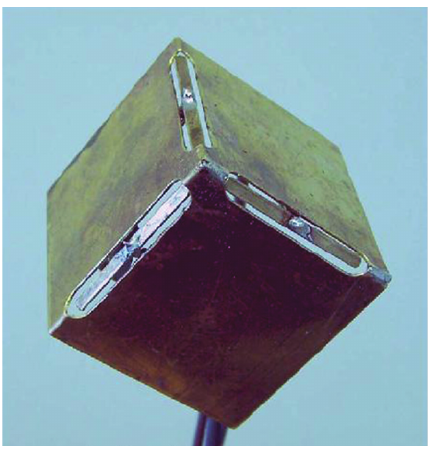
Figure 6: MIMO cube with slot dipoles on edges.